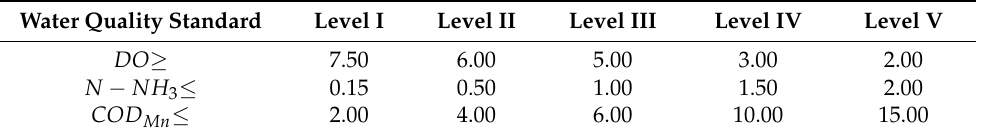
Table 1. Environmental Quality Standards for Surface Water GB3838-2002 (China) [57]. Water Quality